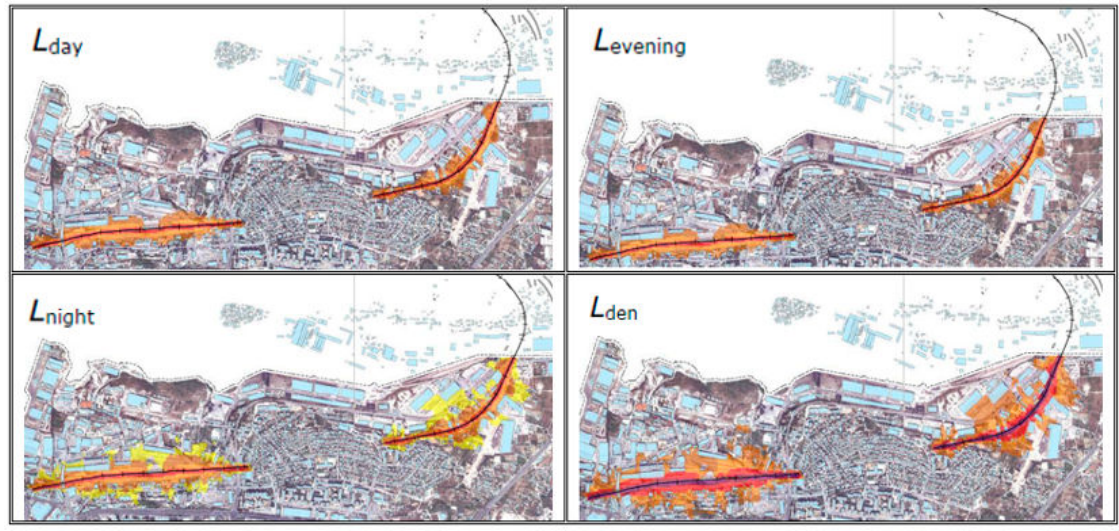
Figure 5. Strategic maps of rail noise sources in the evaluation periods (L day , L evening , L night , L den ) * [55]. * noise indicator class (dB) as in Figure